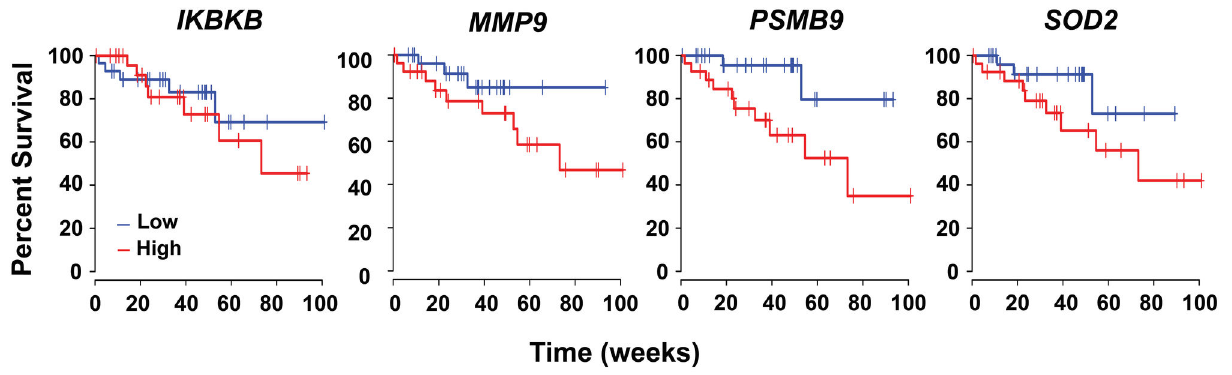
Figure 6. A subset of NF-κB regulators and target genes correlate with poor outcome in ccRCC. Kaplan-Meier survival curves for genes in the NF-κB signature whose increased expression levels significantly correlate with poorer overall survival outcome are shown. Individual gene expression profiles were dichotomized by median split into ‘high’ (red) or ‘low’ (blue) expression groups. Gene names are indicated above each graph. Please see Table S5 for p -values. doi: